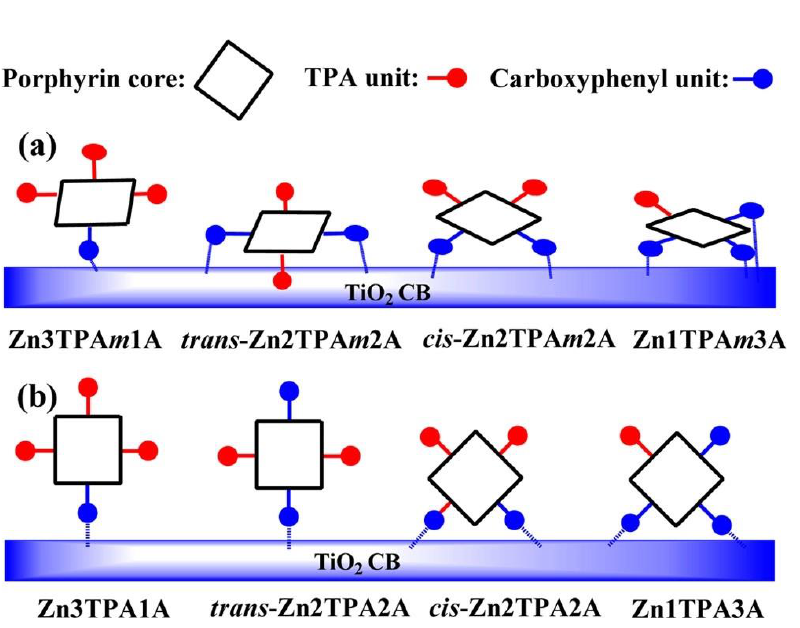
Figure 16. Possible modes of attachments of ( a ) meta - and ( b ) para -series of porphyrins on TiO 2 surface. Members of each series featured increasing numbers of carboxyl-anchoring units (depicted from left to right). TPA = triphenylamine unit. Reproduced from reference [80] with permission from the American Chemical Society, copyright 2015.